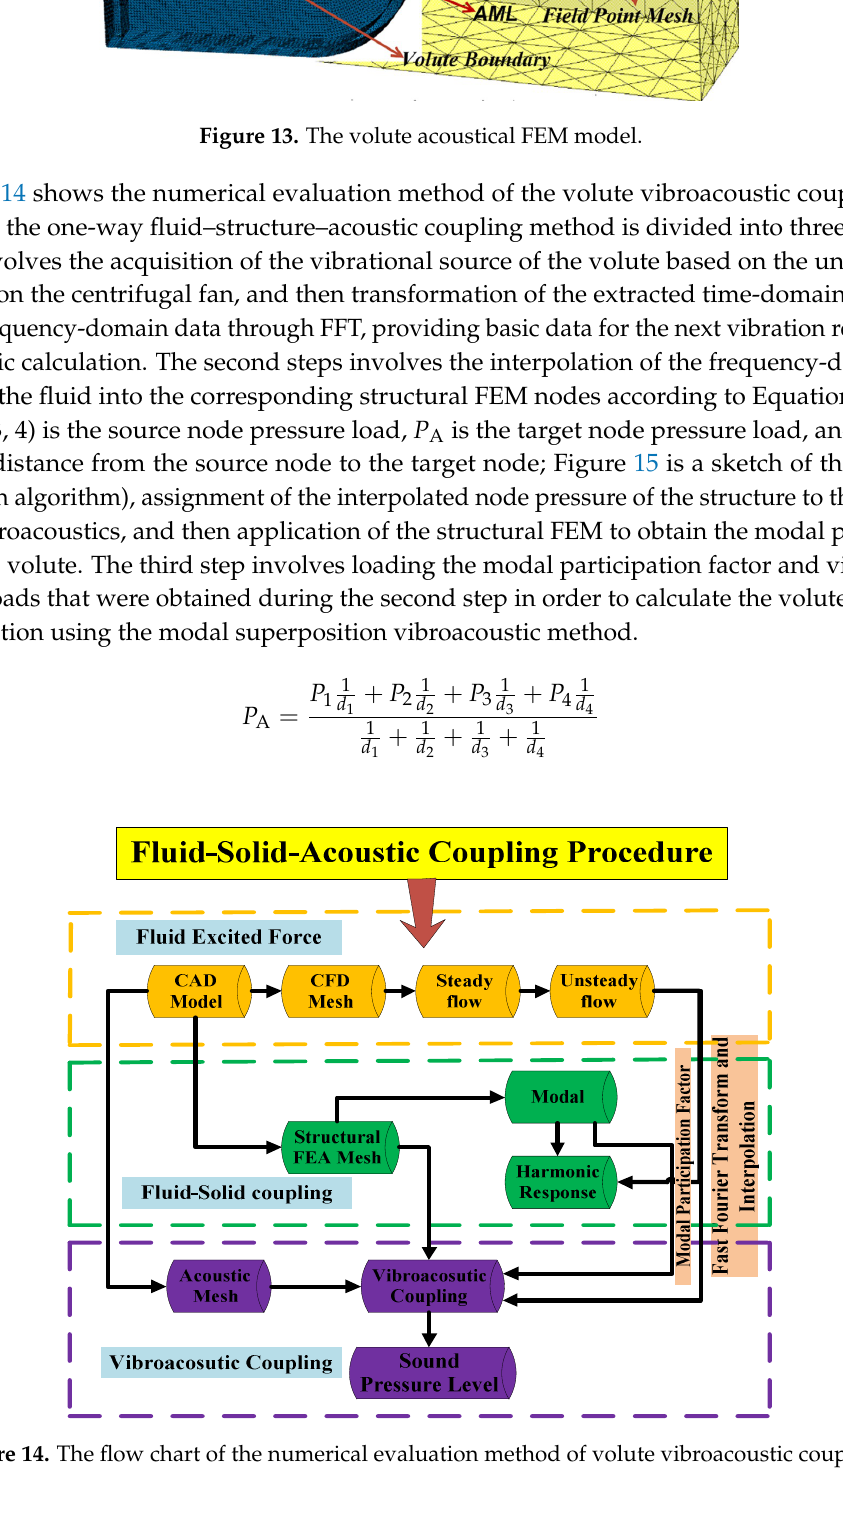
Figure 15. The diagram of the geometric interpolation algorithm.